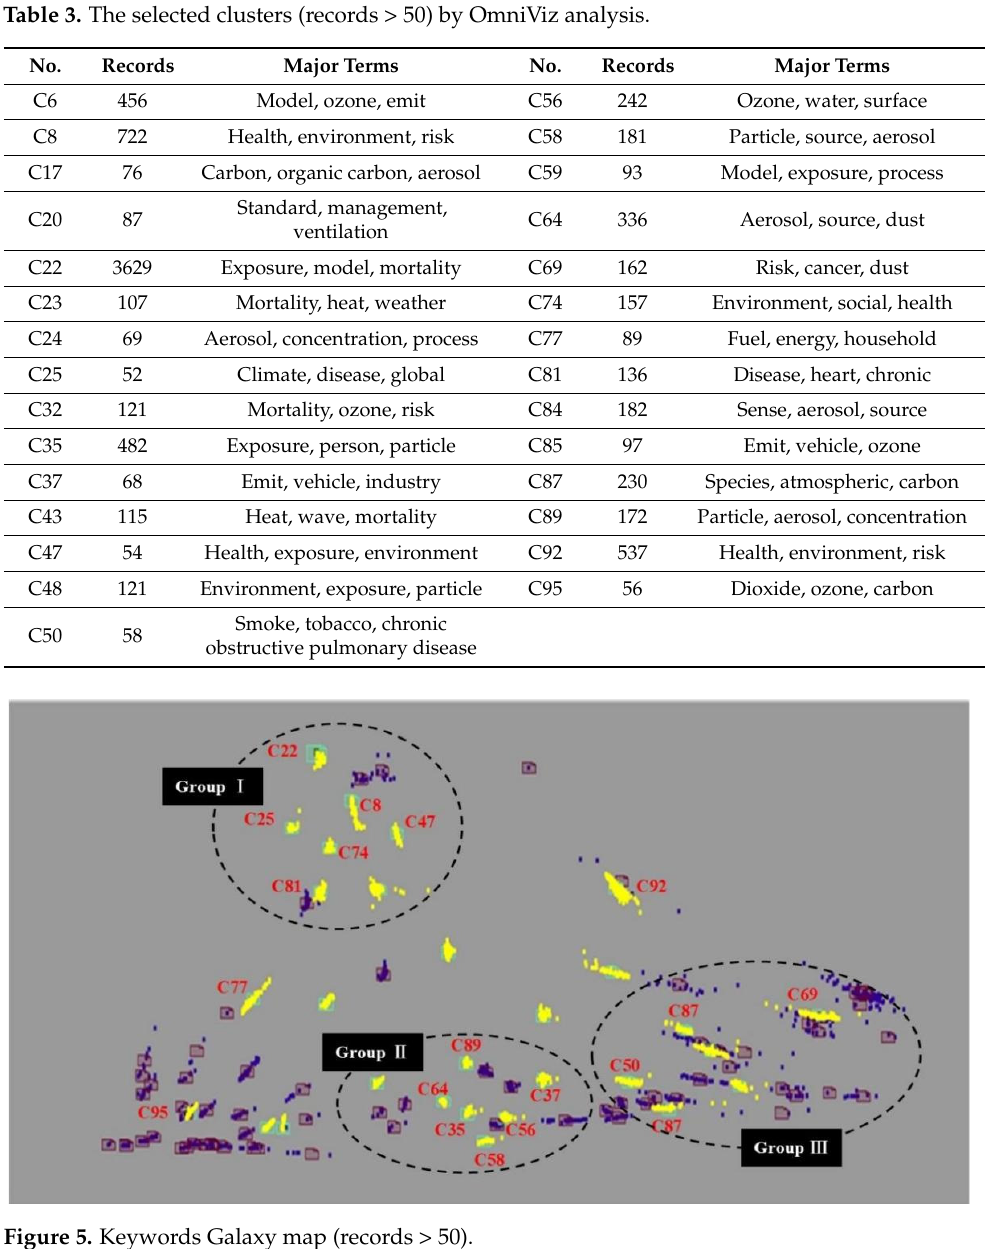
Figure 5. Keywords Galaxy map (records > 50) .